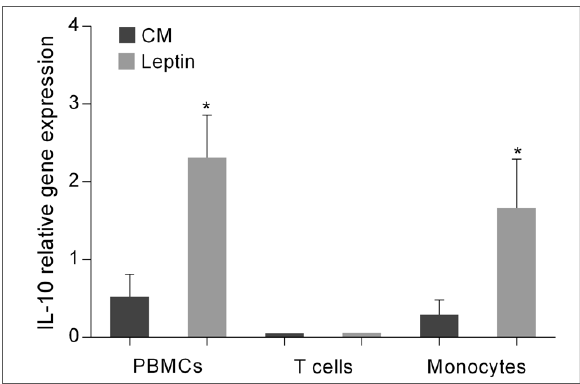
Figure 6. Effect of leptin on IL-10 gene expression in T cells and monocytes isolated from PBMCs from controls and ITP patients in remission that were cultured in plain culture medium (CM) or in the presence 200 ng/mL recombinant human leptin. IL-10 gene expression is shown as mean (SD). Asterisks indicate statistically significant differences (* p < 0.05) compared to controls.